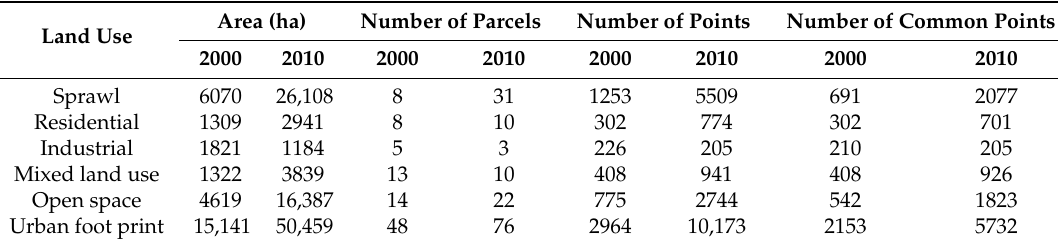
Table 4. Attributes of land-use